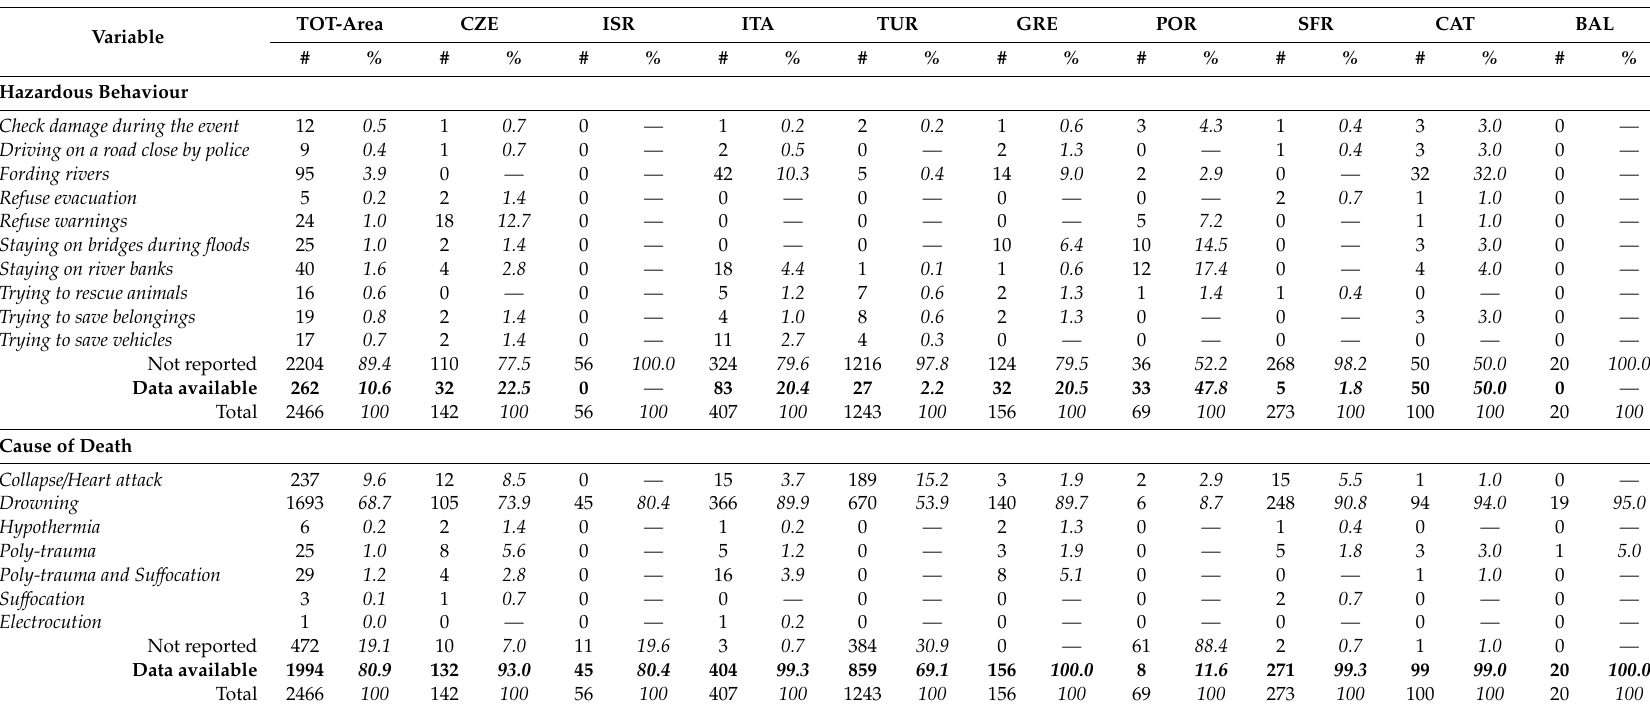
Table A5. EUFF Database: Hazardous Behavior and Cause of Death of fatalities per TOT-A, and per each SA (#: Number; %: Percentage). Data available are in bold and percentage in